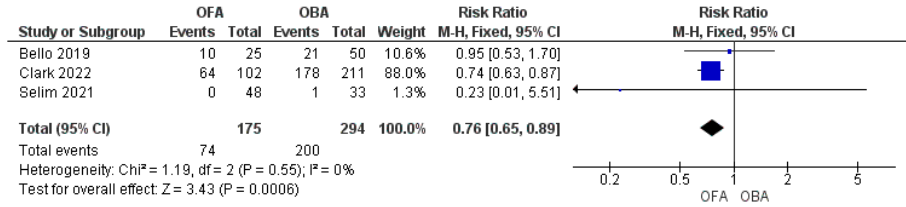
Figure 3. Forest plot of risk ratio to develop complications comparing opioid-free anesthesia and opioid-based anesthesia [16,17,20].